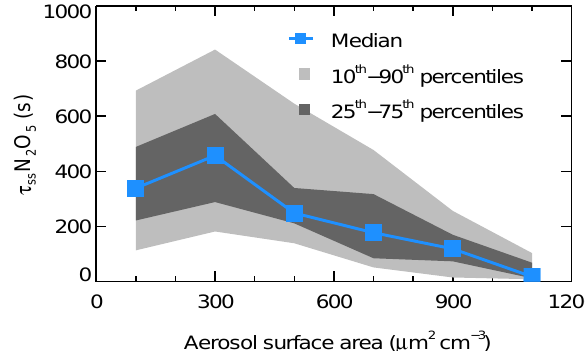
Figure 6. The dependence of N 2 O 5 lifetime on aerosol surface area. Data were selected from 20:00 to 04:00CNST and are shown as medians, 25–75th percentile ranges, and 10–90th percentile ranges, as shown in the